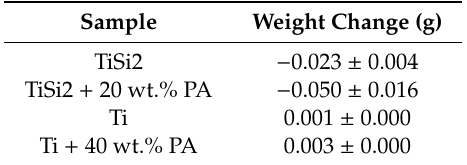
Table 6. The changes in weight after 7 days in SBF